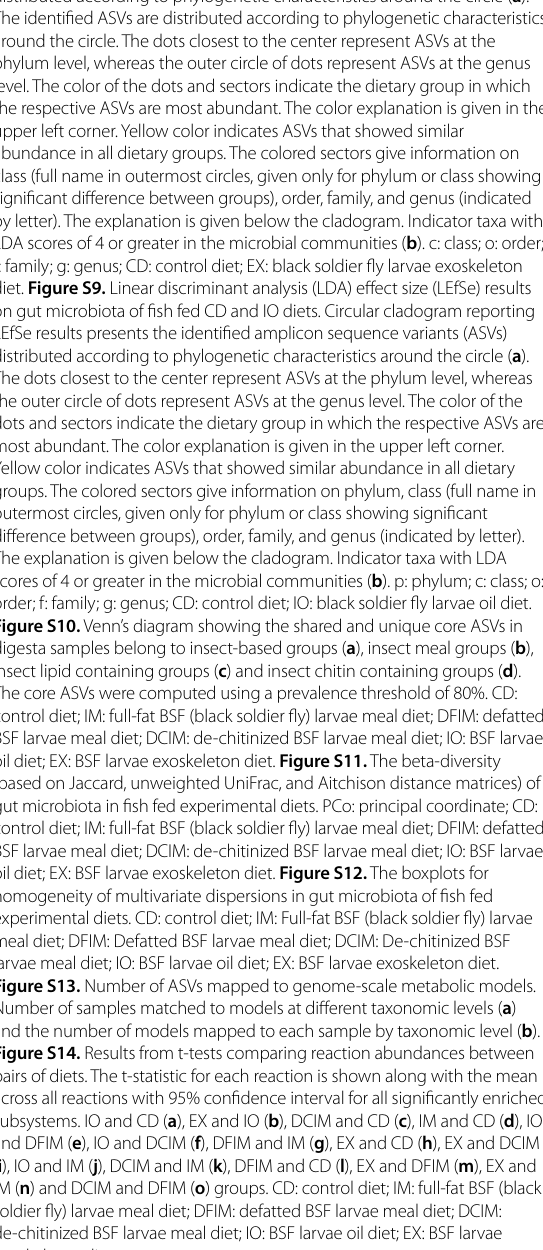
Figure S13. Number of ASVs mapped to genome-scale metabolic models. Number of samples matched to models at different taxonomic levels ( a ) and the number of models mapped to each sample by taxonomic level ( b ). Figure S14. Results from t-tests comparing reaction abundances between